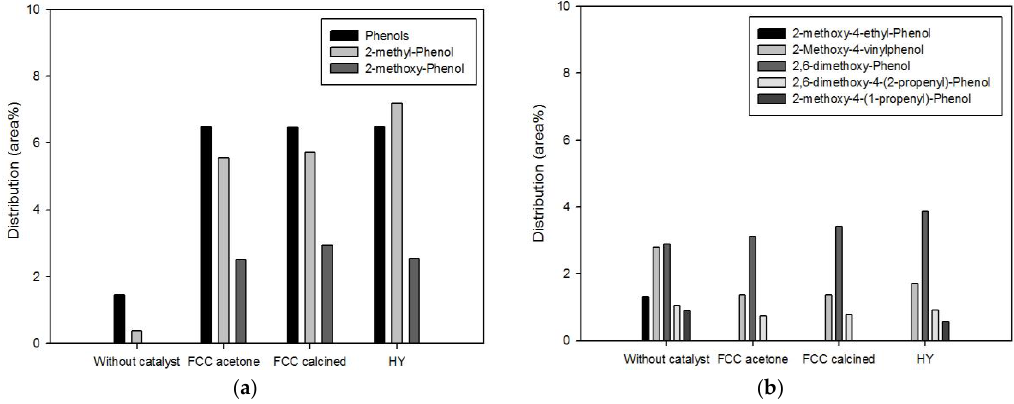
Figure 7. Detailed phenolic species distributions obtained from non-catalytic and catalytic pyrolyses with biomass:catalyst = 1:10: ( a ) small-molecular-mass phenolics; and ( b ) large-molecular-mass phenolics.